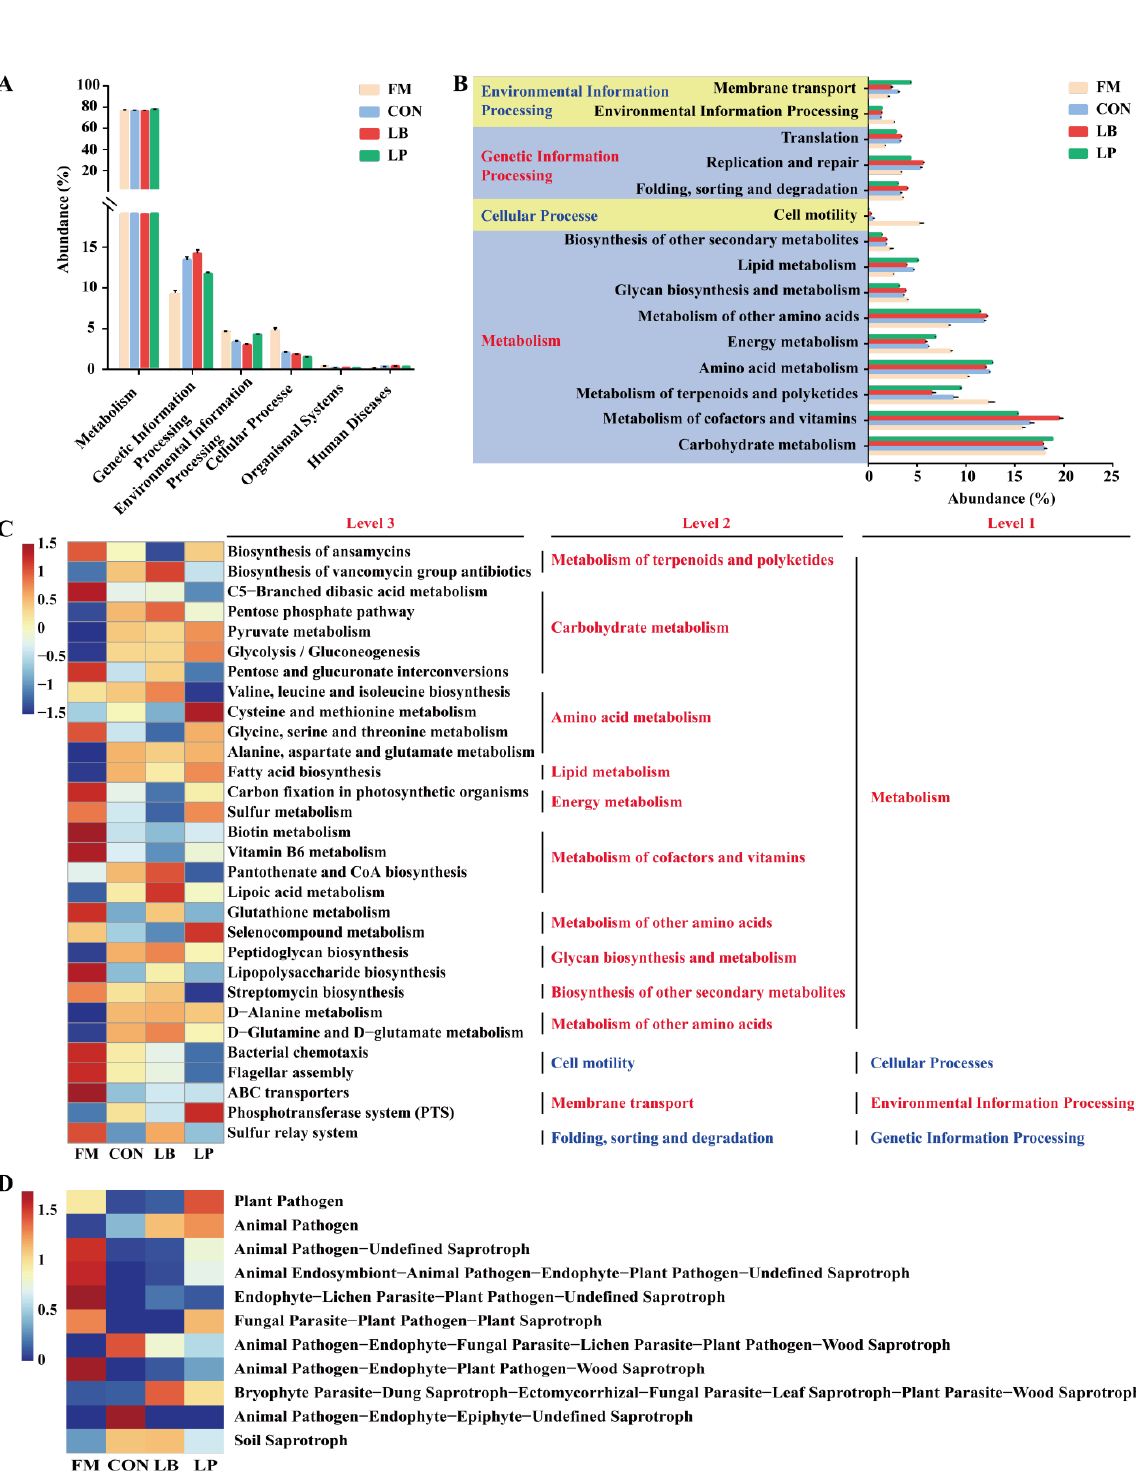
Figure 4. Dynamics of predicted microbial functional profiles in FM and forage oat silage analyzed by PICRUSt for bacteria and FUNGuild for fungi ( n = 3). ( A ) Level 1 metabolic pathways. ( B ) Level 2 Kyoto Encyclopedia of Genes and Genomes (KEGG) orthologue functional predictions of the relative abundances of the top 20 metabolic functions. ( C ) Level 3 KEGG orthologue functional predictions of the relative abundances of the top 30 metabolic functions. ( D ) Variations in the composition of fungal functional groups inferred by FUNGuild. FM, fresh material; CON, control group; LB, Lentilactobacillus buchneri inoculated treatment; LP, Lactiplantibacillus plantarum inoculated